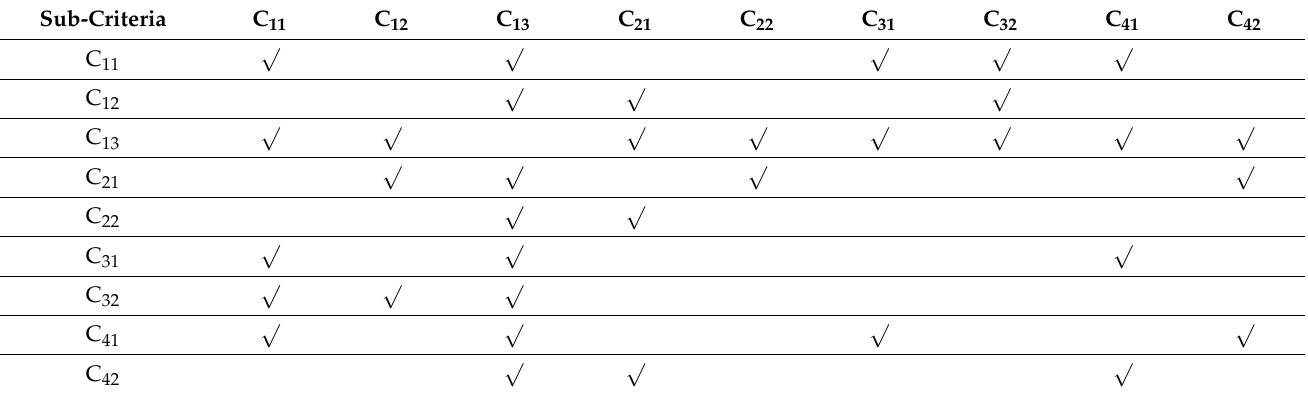
Table 3. Dependences among decision sub-criteria for wind farm site